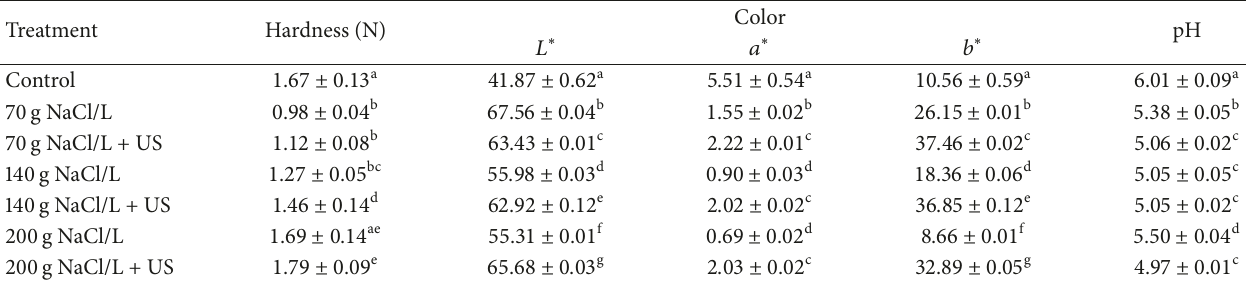
Table 2: Effect of treatments on physicochemical properties of rabbit meat at different salt concentrations (marinating time = 120 min). Treatment Hardness (N)